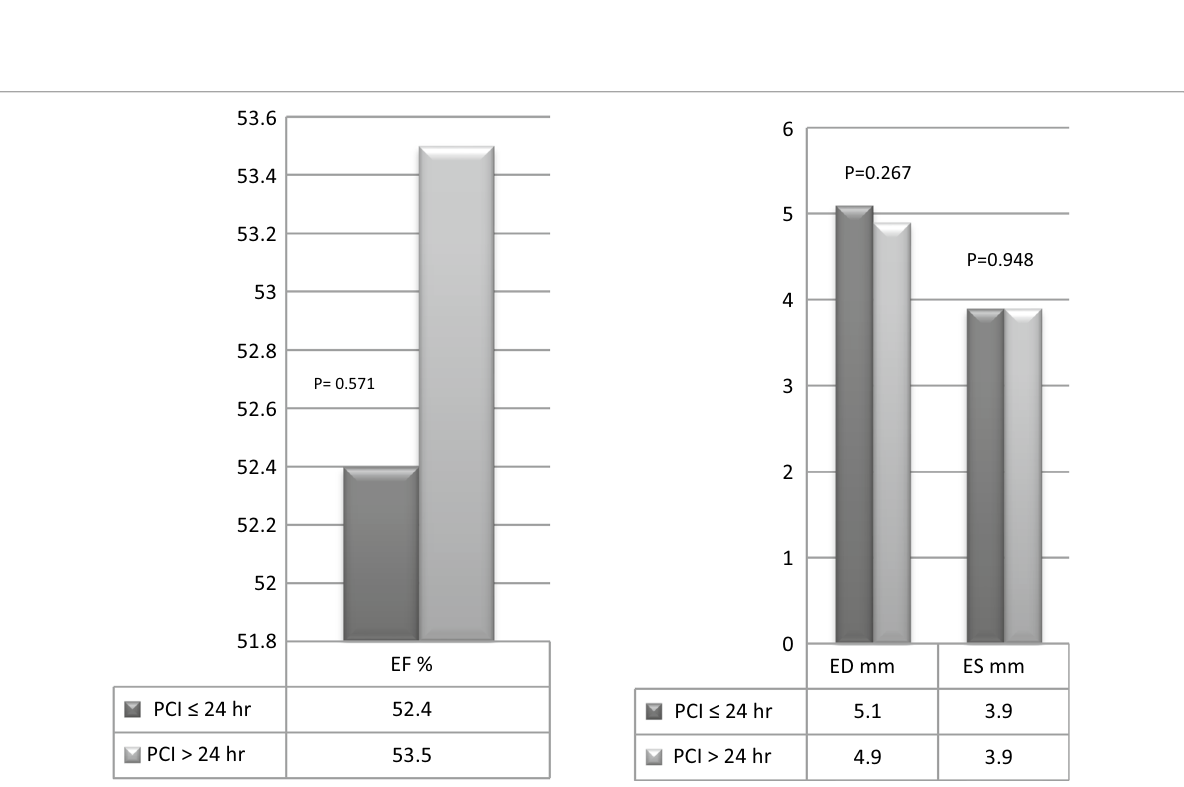
Fig. 2 Myocardial ejection fraction and dimensions. This chart is representing percentage of patients’ myocardial ejection fraction and